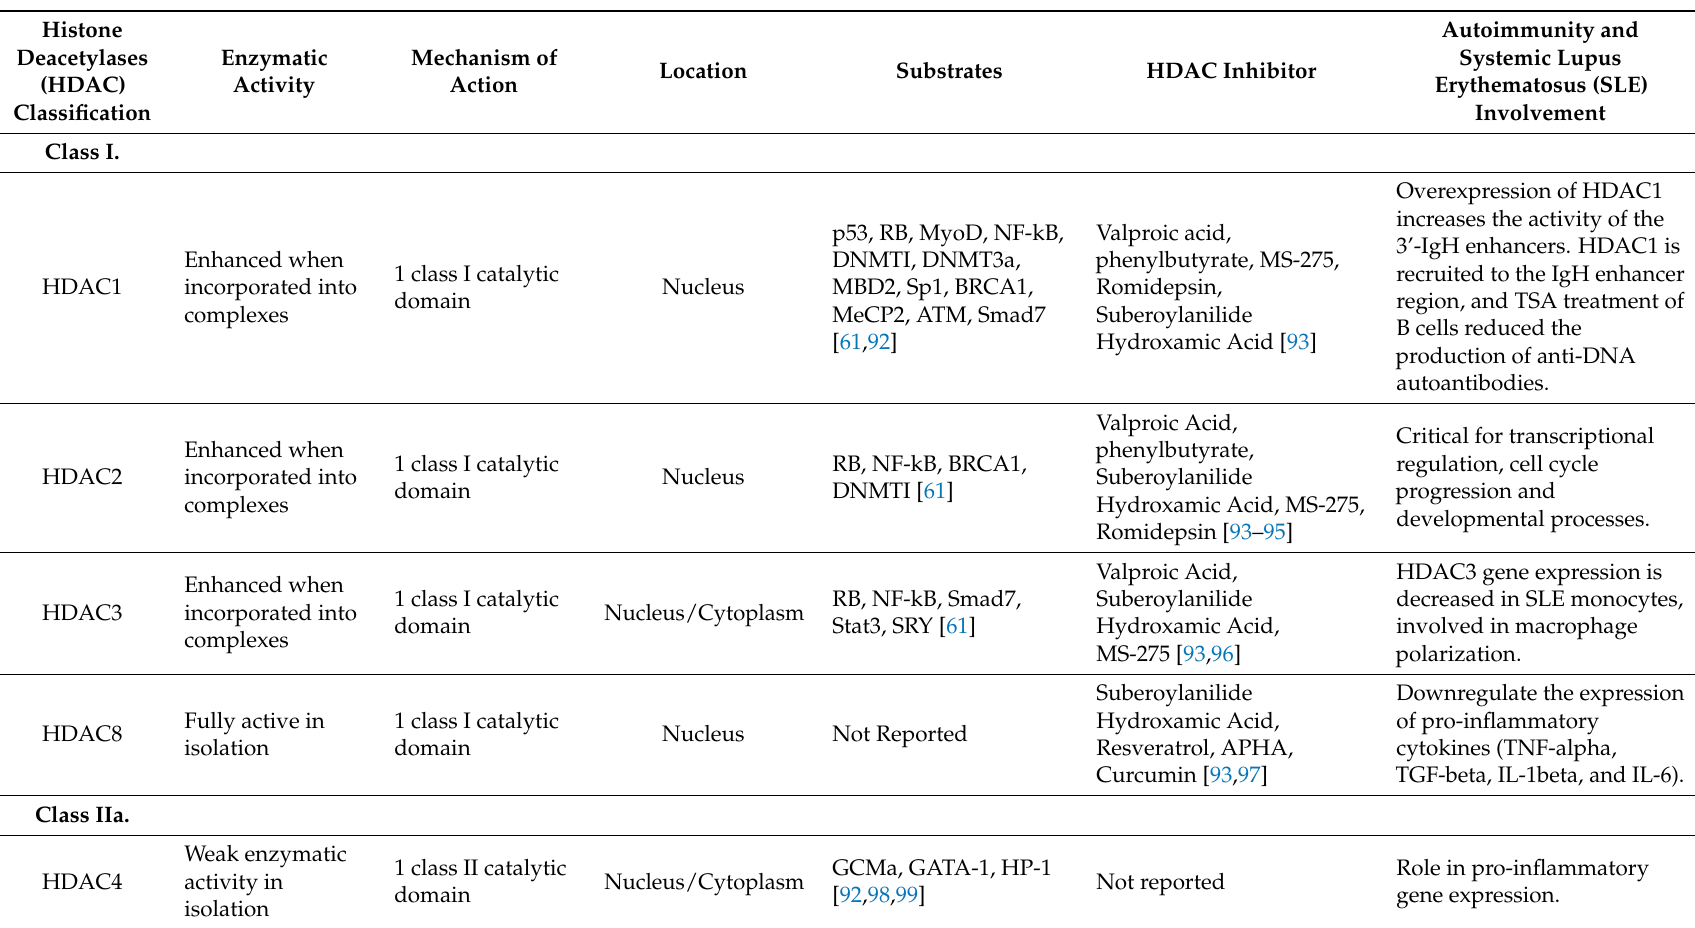
Table 1. Summary of HDAC